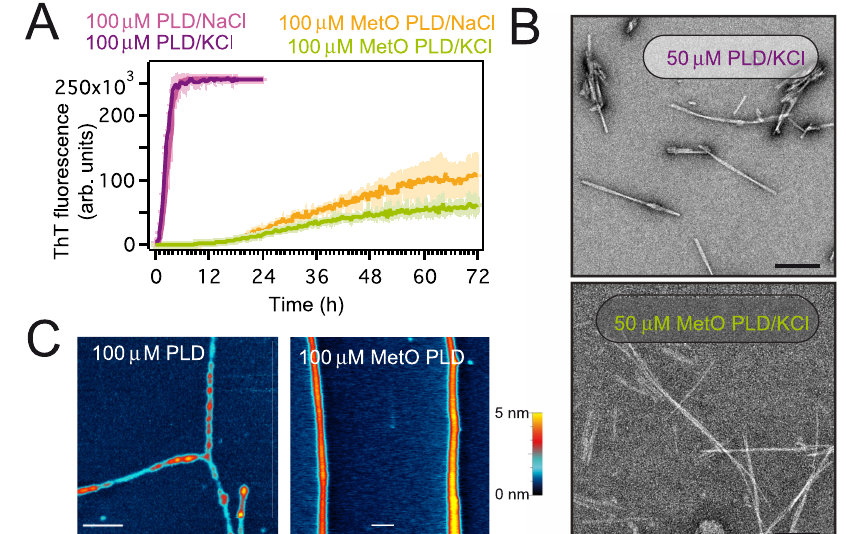
Fig. 2 | MetO PLD forms distinct fi brillar aggregates. A Amyloid aggregation kineticsasmeasuredbyThT fl uorescence.Samplescontainedeither150mMKClor 150mM NaCl, as noted. B Representative electron micrographs showing fi brils formed by 50 μ M PLD and MetO PLD aged for 20 days. Scale bars correspond to 200nm. C Atomic force microscopy topographic characterization of the fi brils